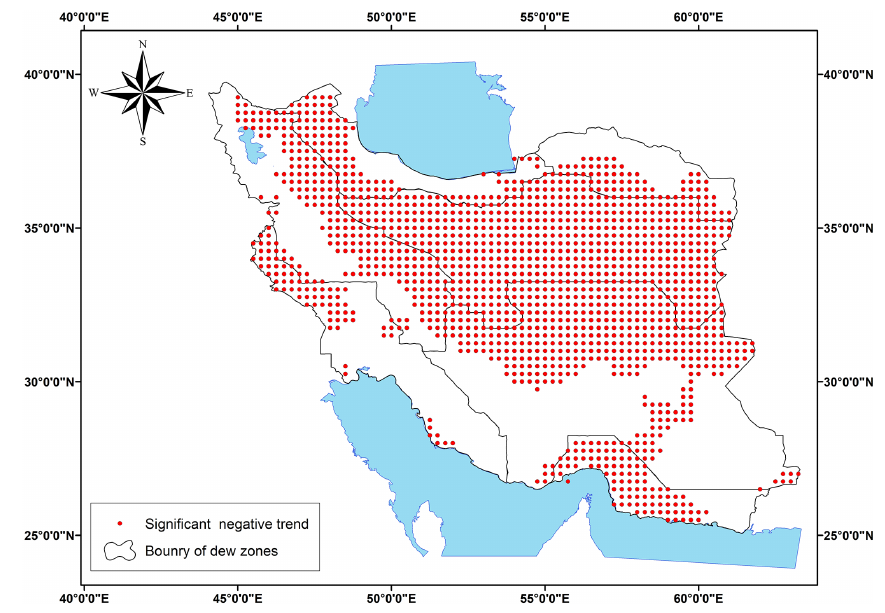
Figure 9. Mann–Kendall trend test on mean yearly dew yield over the years 1979–2018 as predicted by Sen’s slope estimator. Only locations with a statistically significant trend ( p < 0 . 05) are shown. Red points present locations with a negative trend regardless of their decreased values, and the white parts did not show any significant trend at ( p < 0 .